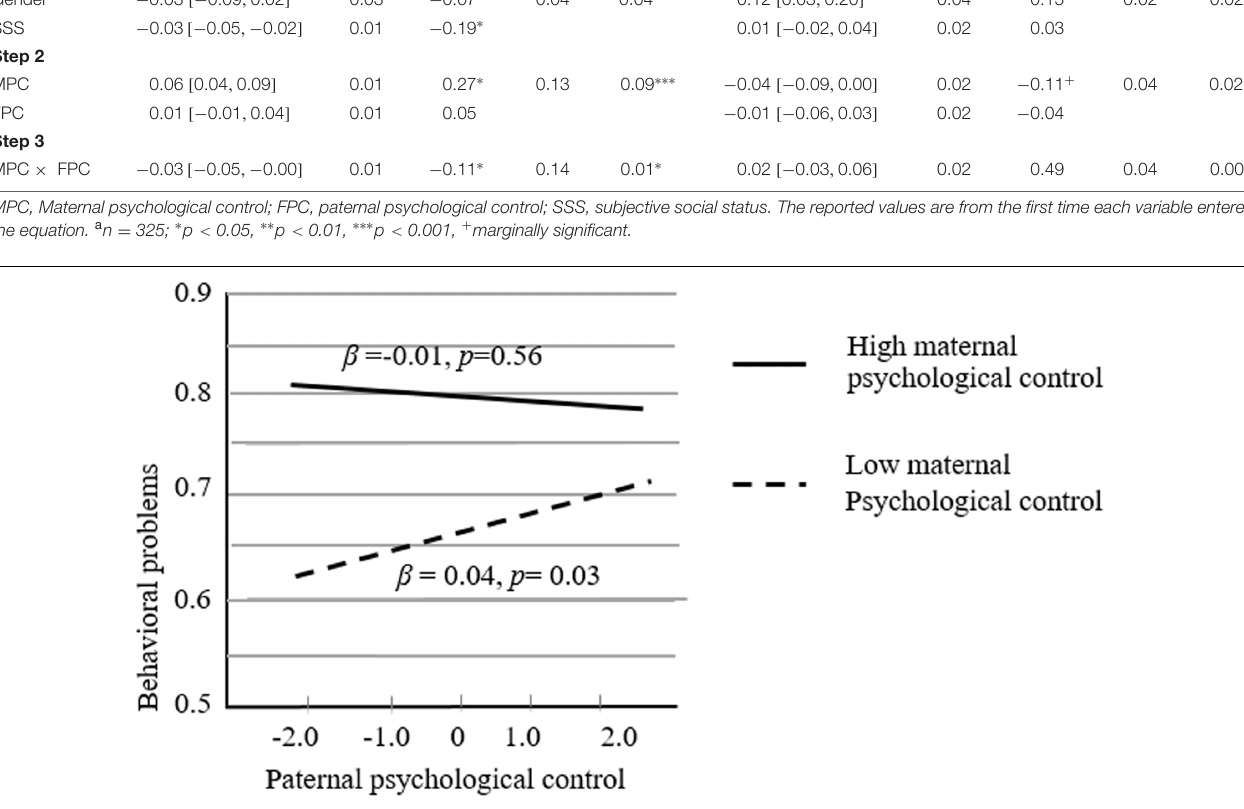
FIGURE 1 | The joint effect of paternal and maternal psychological control (paternal psychological control as the independent variable and maternal psychological control as the